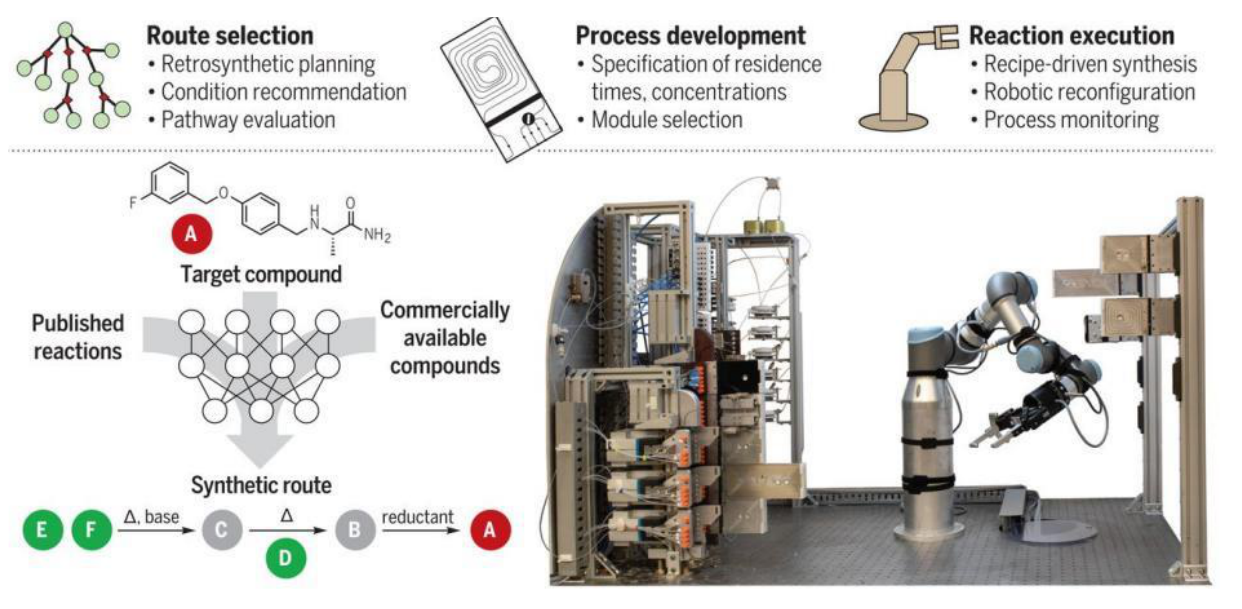
Figure 8. The plug-and-play continuous flow chemical synthesis system. Reproduced with permis- sion from [Coley, C.W.; Thomas, D.A.; Lummiss, J.A.M.; Jaworski, J.N.; et al], [Artificial Intelligence